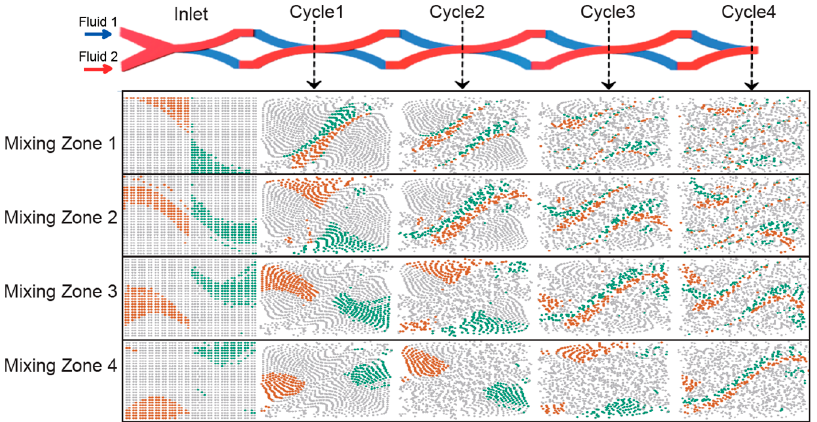
Figure 7. The inlet plane is composed of four mixing zone groups, which are fully mixed in different cycles sequentially. For each mixing zone group, its Fluid 1 and Fluid 2 sections are colored brown and green, respectively. The transformation and reallocation of fluid distributions in the first four mixing cycles are visualized accordingly.